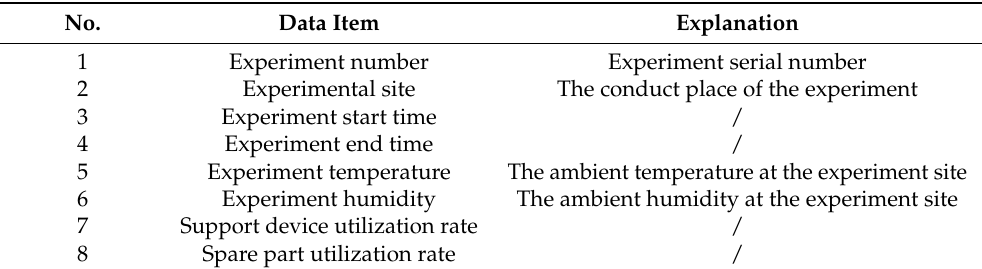
Table 1. The attribute information of ILS experiment data.